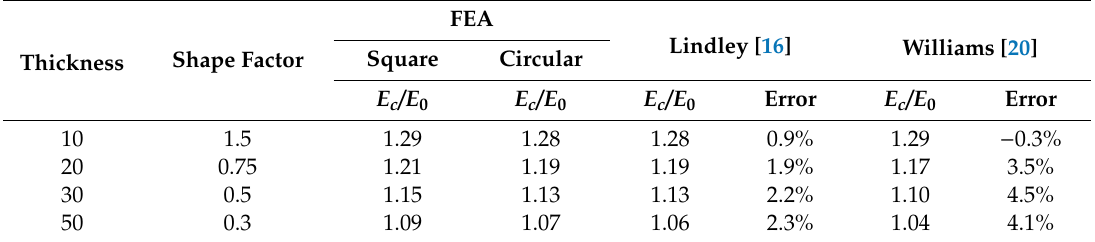
Table 1. Comparison of models to estimate the ratio of apparent compression modulus and Young’s modulus.